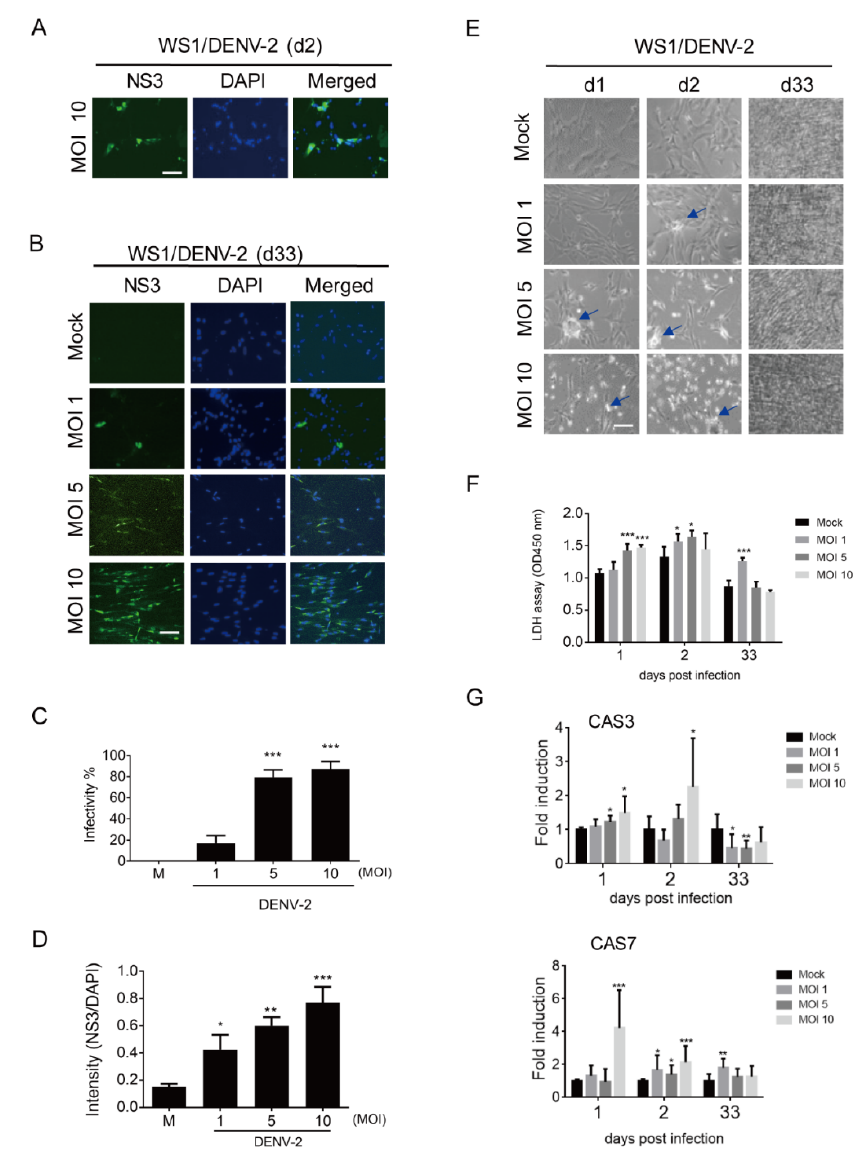
Figure 1. Long-term infection of dengue virus (DENV)-2 in WS1 (human dermal fibroblast) cells. ( A ) 4 × 10 4 WS1 cells were infected with mock or DENV-2 multiplicities of infection (MOI) 10 for 2 days, the DENV-2 infected cells were detected by immunofluorescence assay with anti-NS3 antibody (green). The images merged with 4 (cid:48) ,6 (cid:48) -diamidino-2-phenylindole (DAPI) staining of cell nuclei (blue) are also shown, scale bar: 100 µ m. ( B ) The immunofluorescence assay was conducted with DENV-2 (MOI 1, 5, and 10) infected WS1 cells at day 33 post infection. ( C ) According to the immunofluorescence data of prolonged infection, the DENV-2 infectivity was cultured with cells expressed NS3. ( D ) The immunofluorescence intensity of NS3 vs. DAPI on day 33 post-infected cells. ( E ) The morphologies of DENV-2 infected WS1 cells were observed and captured by phase contrast light microscopy at days 1, 2, and 33 post-infection. The arrows indicate the spots of cytopathic e ff ect (CPE). ( F ) Lactate dehydrogenase (LDH) cell cytotoxicity assay was conducted with culture medium harvested at days 1, 2, and 33 post-infection. (G) Quantitative reverse-transcription polymerase chain reaction (qRT-PCR) analysis of mRNA expression of caspase 3 ( CAS3 , upper panel) and caspase 7 ( CAS7 , lower panel) in WS1 cells (4 × 10 4 ) infected with DENV-2 (MOI 1, 5, and 10) for 1, 2, and 33 days. Relative mRNA expression normalized to that of glyceraldehyde-3-phosphate dehydrogenase (GAPDH), and the fold induction to mock control. Data are shown as means ± standard deviation (SD, n = 3). Student’s t -test *, p < 0.05; **, p < 0.01; ***, p < 0.001 compared with mock infection groups.